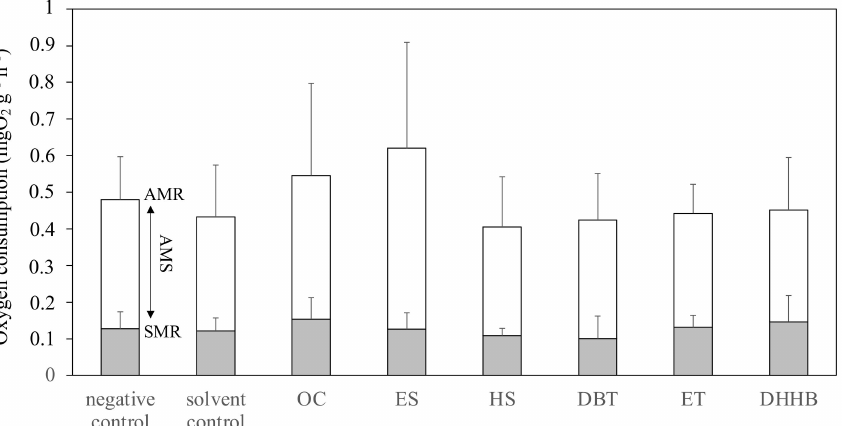
Figure 2. Active metabolic rate (AMR), standard metabolic rate (SMR), and aerobic metabolic scope (AMS) of 5 dpf Danio rerio larvae in the controls or after exposure to one of the six UV filters tested: OC, ES, HS, DBT, ET, and DHHB. The results are expressed as the mean values ± standard deviation. No significant difference was observed between the solvent control and UV filters, regardless of the metabolic rate considered ( t -test, p <